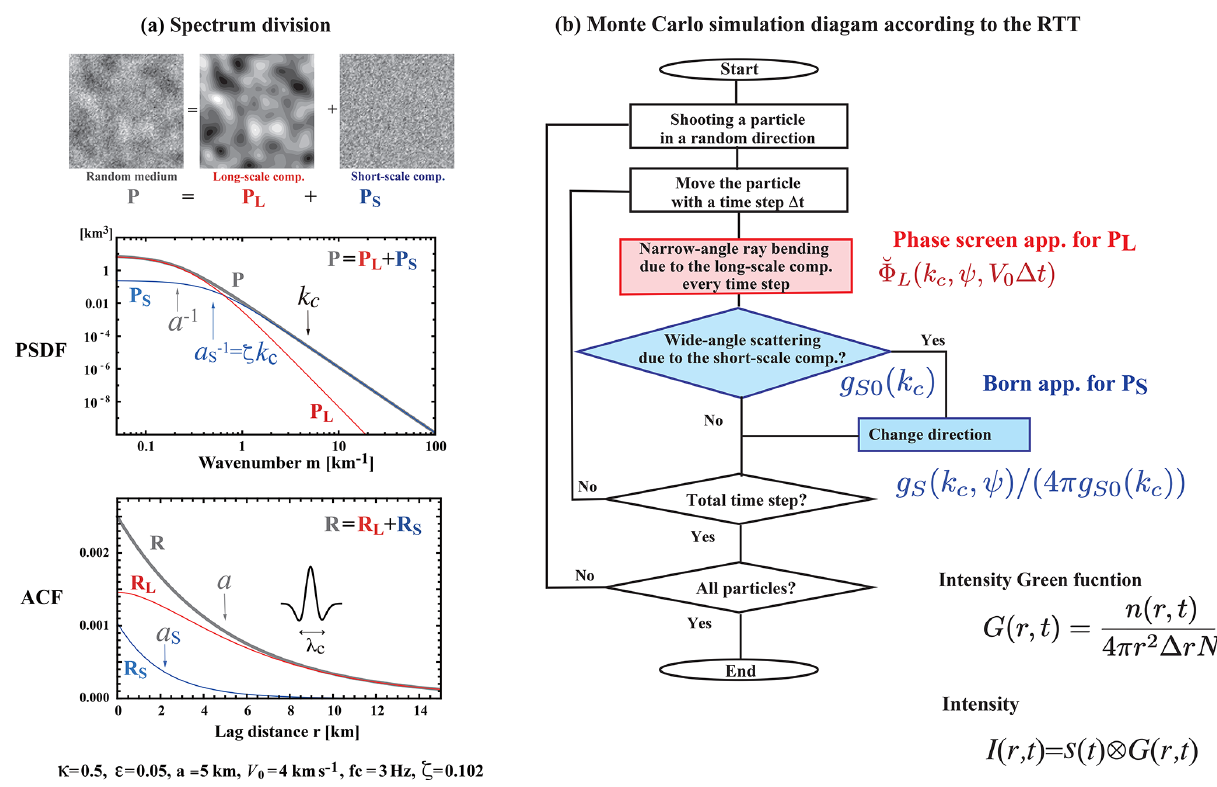
Figure 10. Spectrum division method. (a) Division of P into two components, P S and P L , with respect to the center wavenumber of a wavelet k c as a reference, where ζ is a tuning parameter. (b) Flowchart of the Monte Carlo simulation according to the RTT with the spectrum division method. Modified from Sato and Emoto